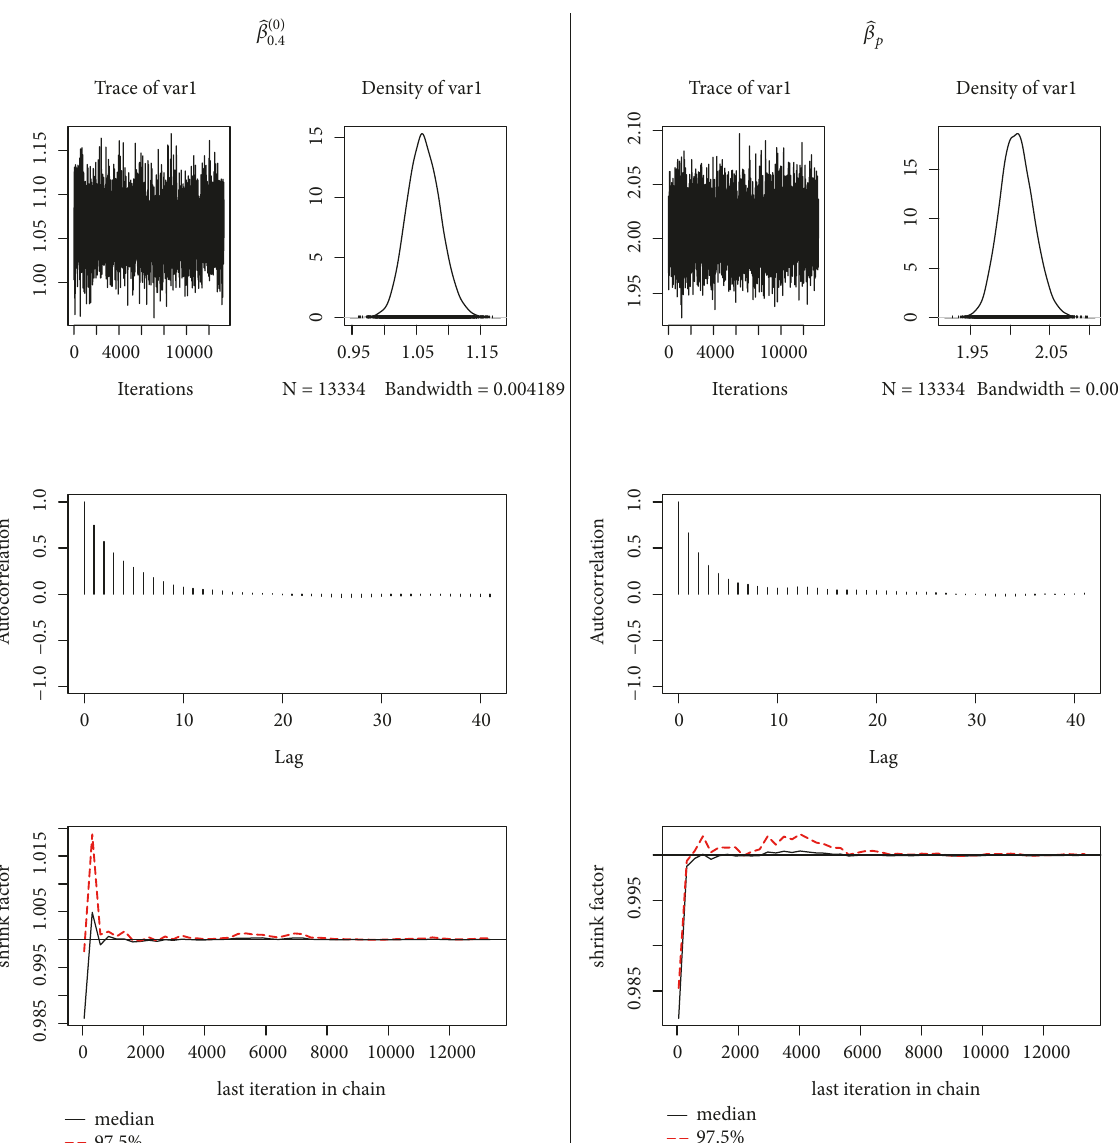
̂ 𝛽 (0) 0.4 (left panel) of the